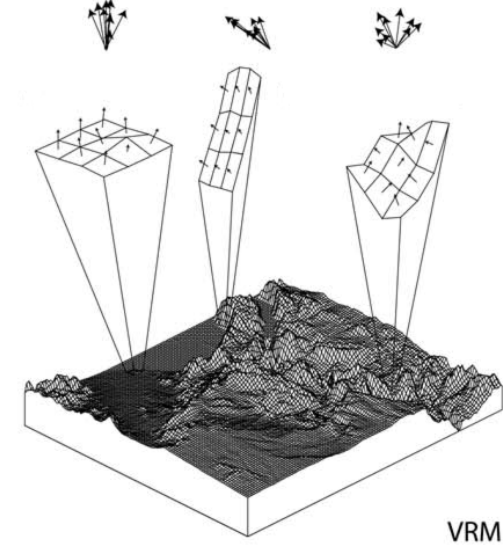
Figure 1. The graphic shows the measurement principle of vec- tor dispersion methods. The dispersion of vectors perpendicular to the terrain surface defines the degree of surface roughness. Graphic from Sappington et al. (2007).